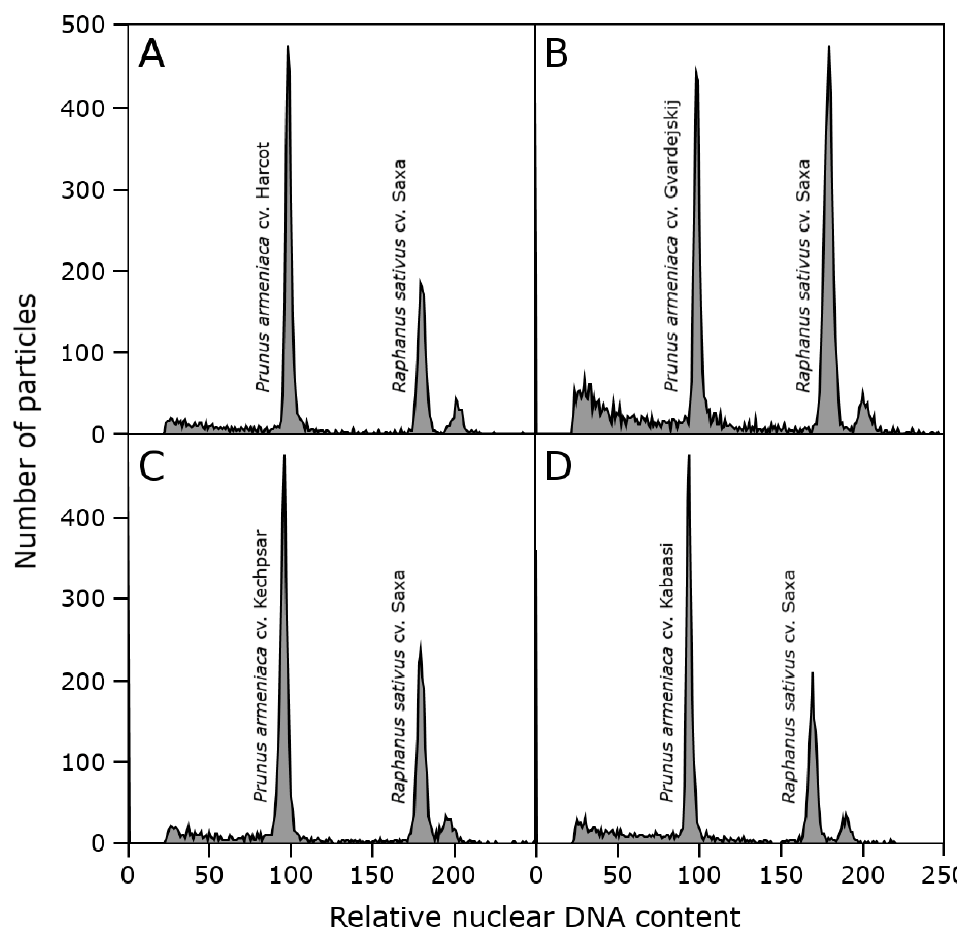
Figure 2. A histogram of the relative nuclear DNA content obtained after a flow cytometric analysis of propidium iodide-stained nuclei isolated from P. armeniaca (( A )—Harcot, ( B )—Gvardejskij, ( C )—Kechpsar, ( D )—Kabaasi) together with internal standard Raphanus sativus cv. Saxa.